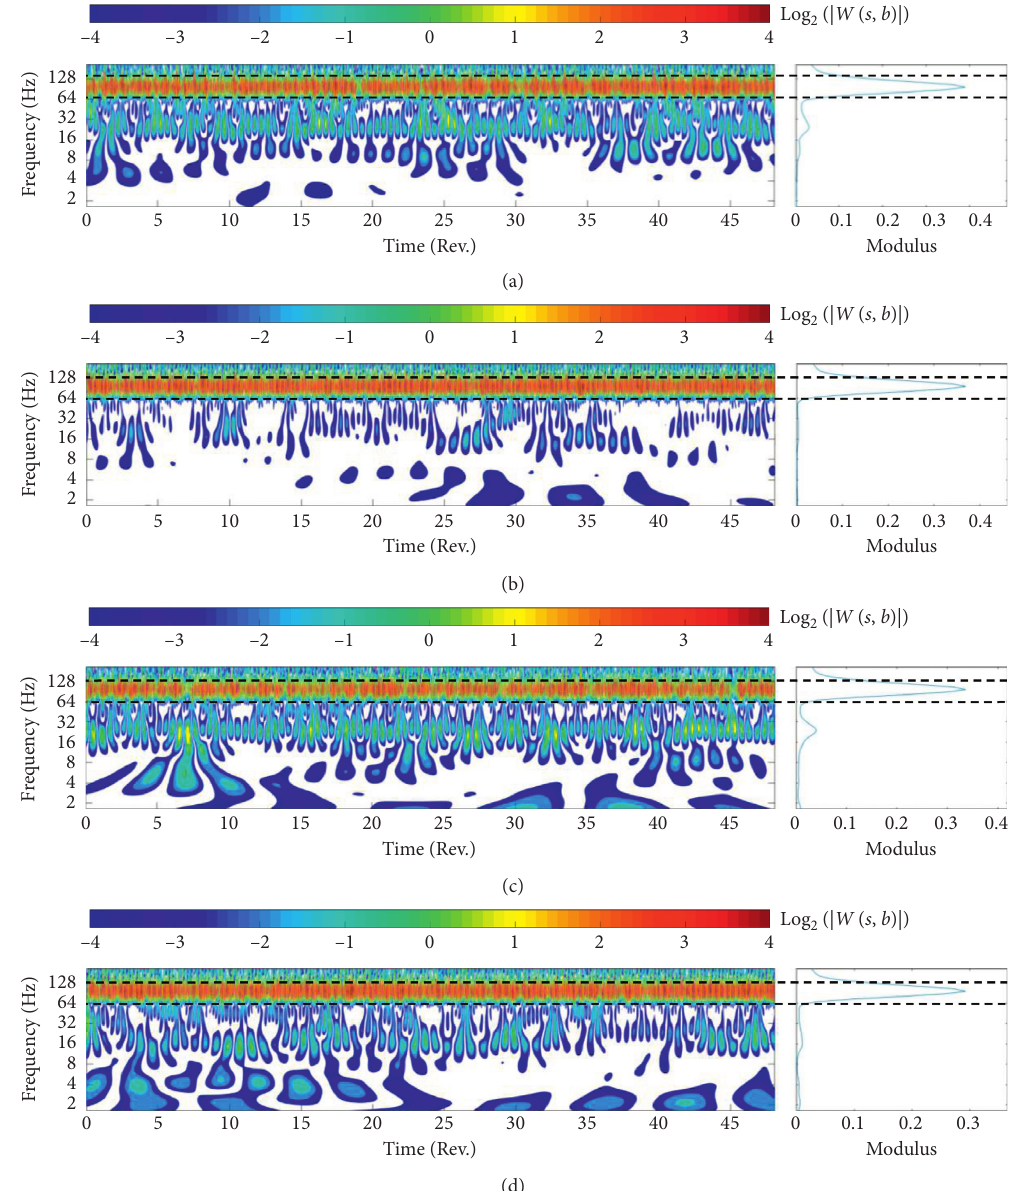
Figure 8: Wavelet modulus spectrum of pressure pulsation at impeller middle with different tip clearances. (a) t � 0.2mm. (b) t � 0.5mm. (c) t � 0.8 mm. (d) t � 1.1